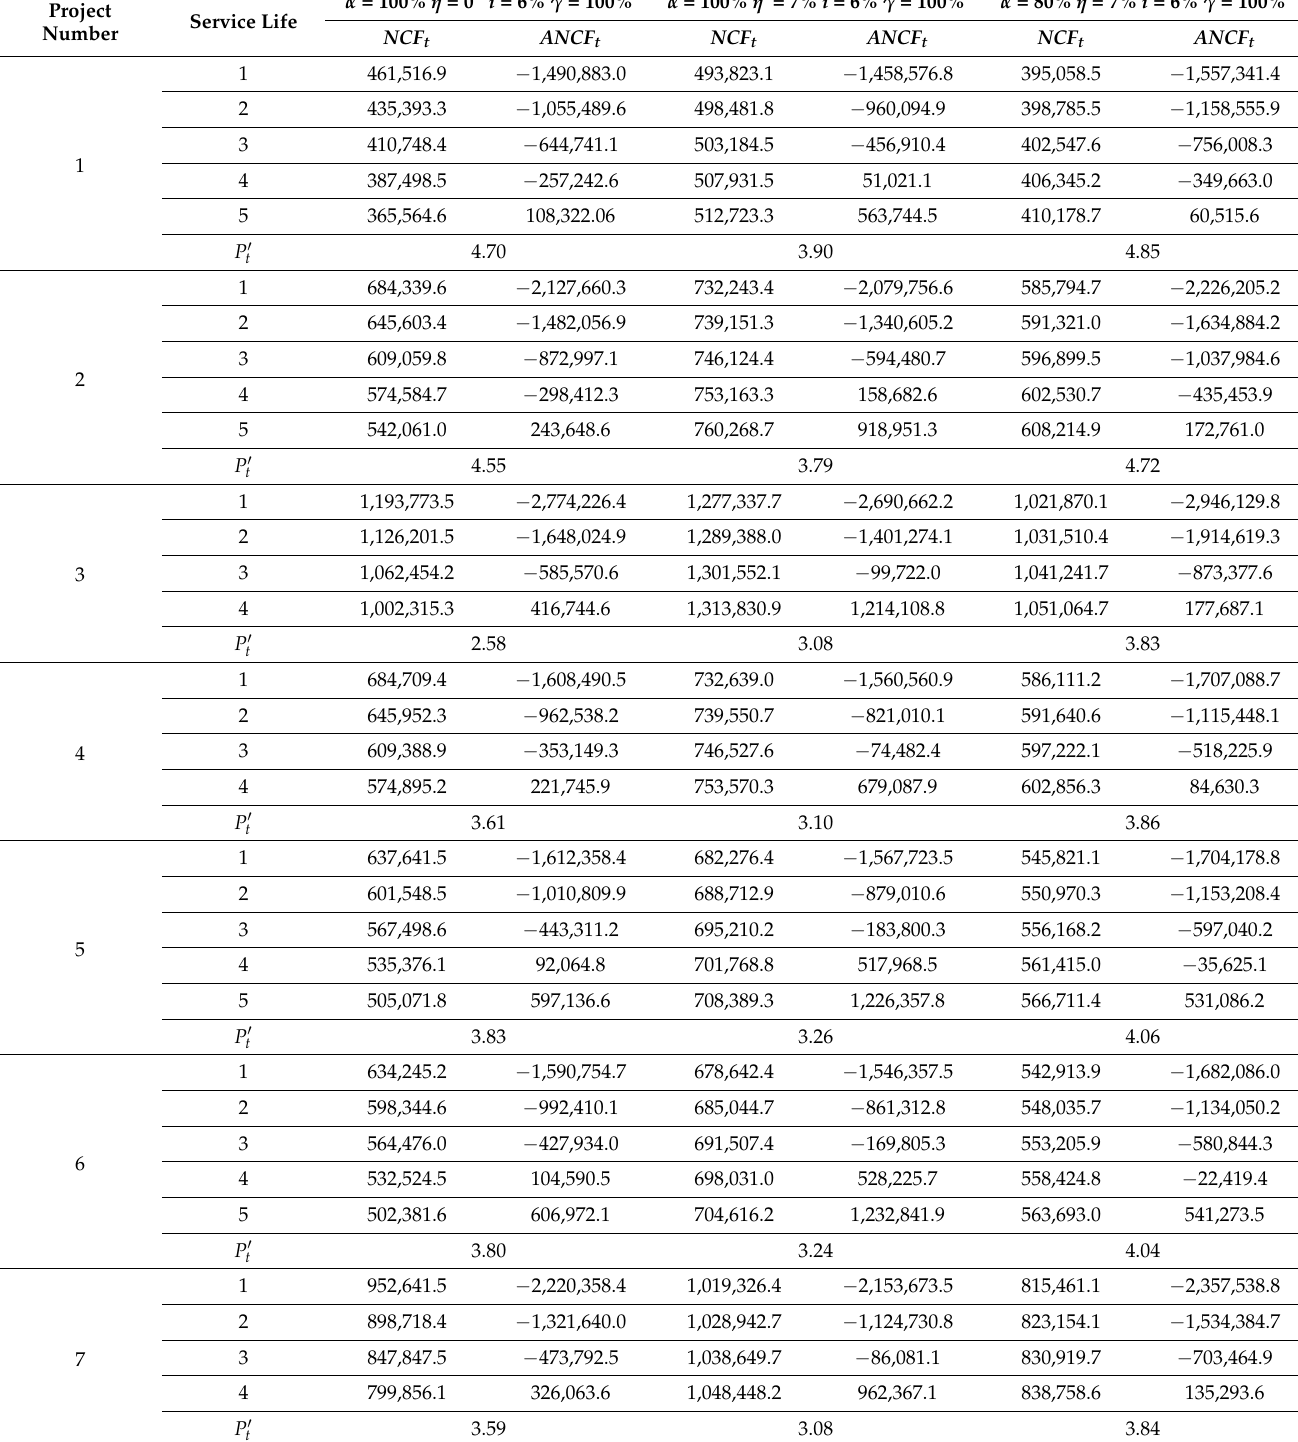
Table 4. Net cash flow, cumulative net cash flow, and dynamic investment recovery